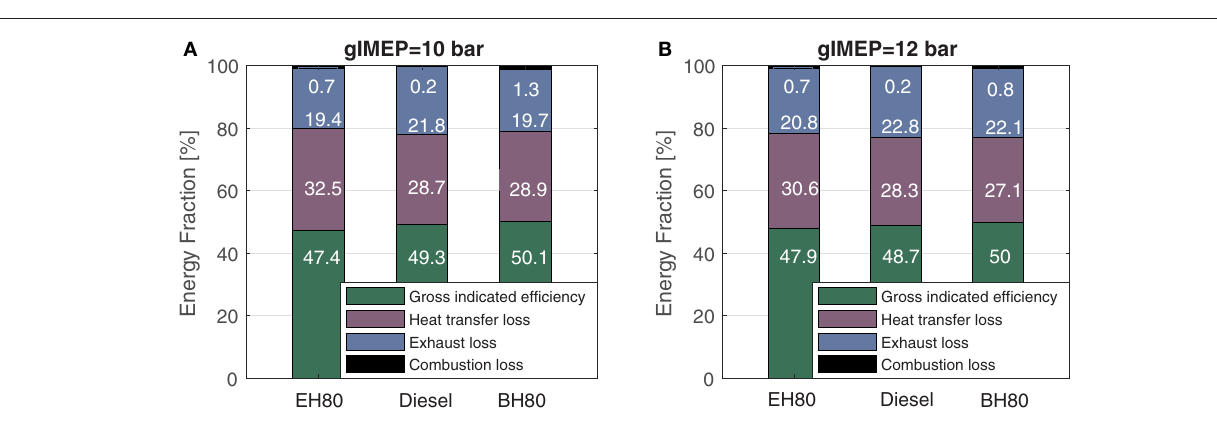
FIGURE 13 | Energy balance analysis. (A) gIMEP = 10 bar. (B) gIMEP = 12